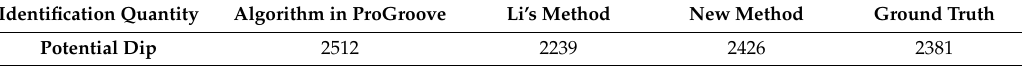
Table 2. Identified Dip Quantity Comparison with three Different Methods.